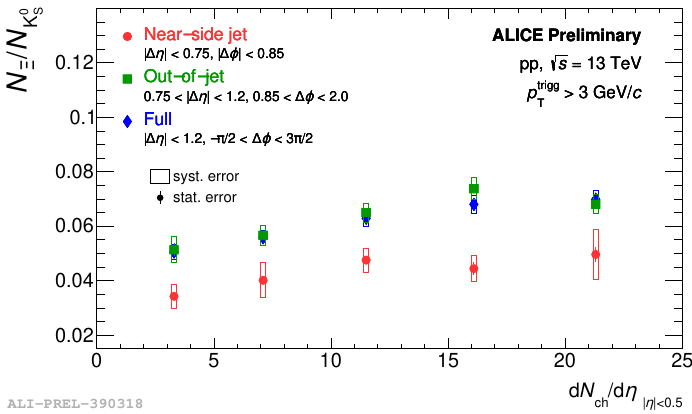
Figure 2: Ratio between Ξ and K 0 at